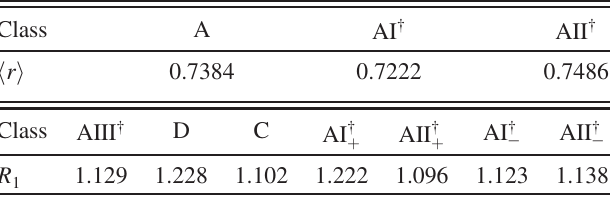
TABLE III. Universal single-number signatures of the non- Hermitian universality classes without reality conditions.